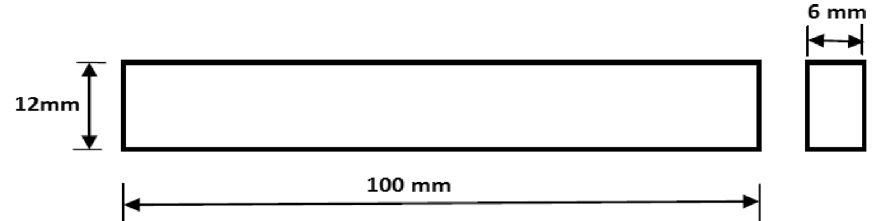
Figure 6. Dimension of flexure test sample.